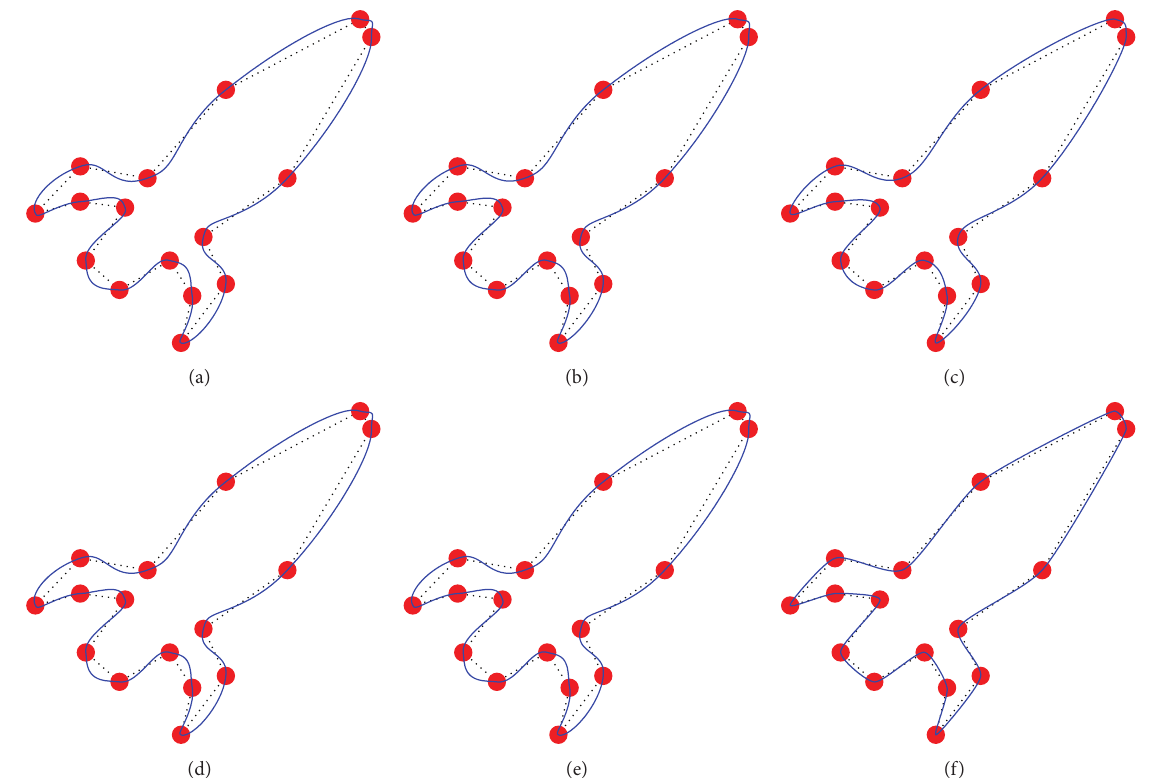
Figure 6: Effect of the parameters on the shape of the curve: (a) 𝛼 𝑖 = 100 , 𝛽 𝑖 = 2 , 𝛾 𝑖 = 2 , 𝛿 𝑖 = 100 ; (b) 𝛼 𝑖 = 10 , 𝛽 𝑖 = 2 , 𝛾 𝑖 = 2 , 𝛿 𝑖 = 10 ; (c) = 2 , 𝛽 = 2 , 𝛾 = 2 , 𝛿 = 2 . Effect of the parameters on the shape of the curve: (d) 𝛼 𝛼 𝑖 𝑖 𝑖 𝑖 = 0.01 , 𝛿 = 10 ; (f) 𝛼 = 2 , 𝛽 = 0.9 , 𝛾 = 0.9 , 𝛿 = 2 𝛾 𝑖 𝑖 𝑖 𝑖 𝑖 𝑖